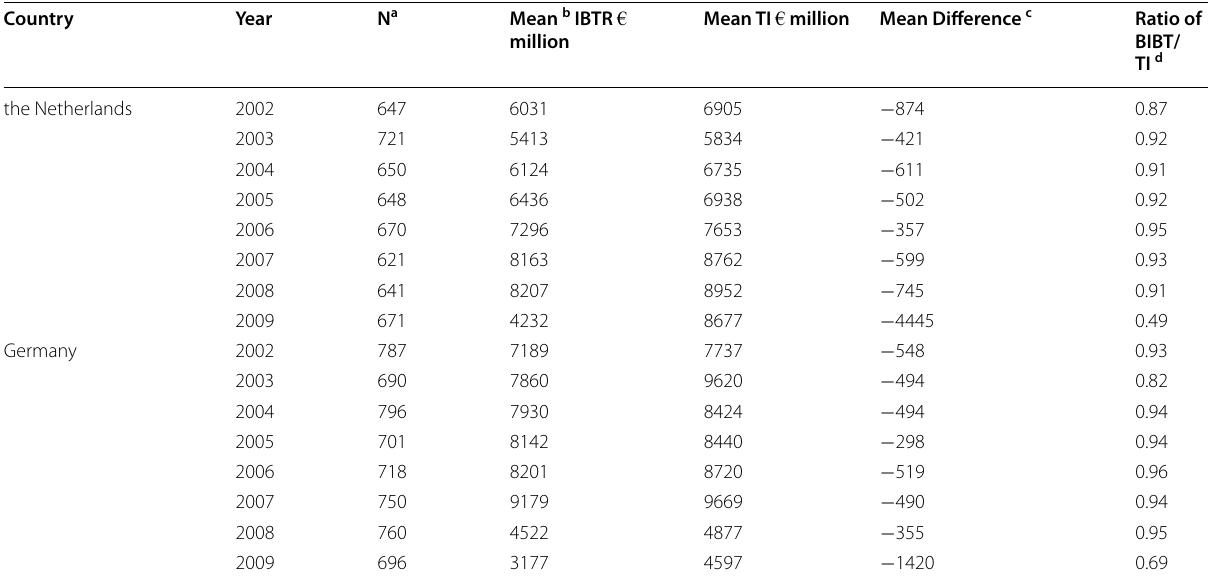
Table 1 Book income before tax (BIBT) and taxable income (TI) in the Netherlands and Germany from